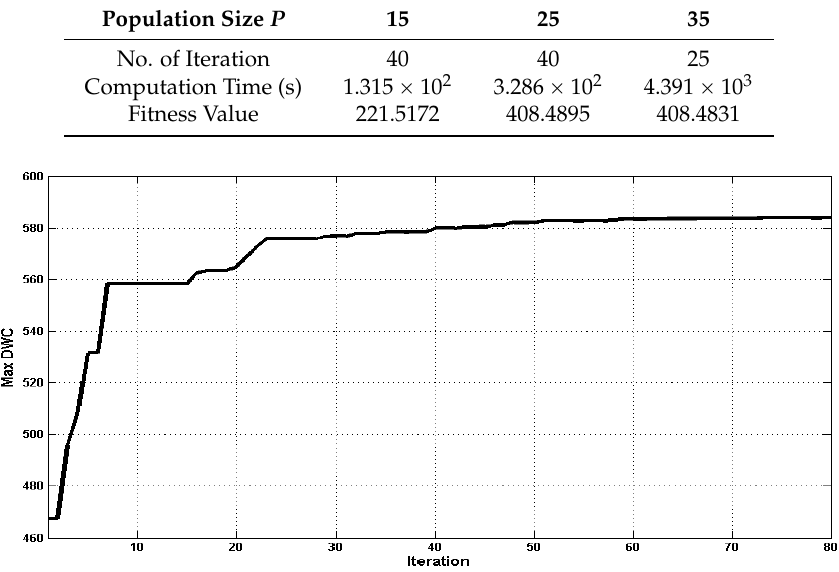
Table 1. Convergence analyses for different particle numbers.